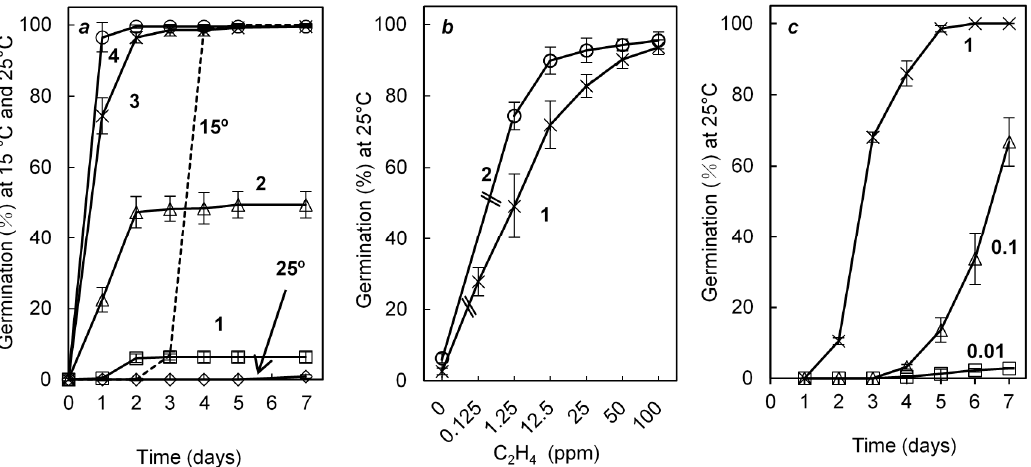
Figure 1. Effects of temperature ( a ), ethylene ( b ) and GA 3 ( c ) on the germination of dormant Col-0 seeds. ( a ) germination at 15 ◦ C (—) and 25 ◦ C (indicated by arrow, open diamonds), and at 25 ◦ C after one (1), two (2), three (3), and four (4) days of incubation at 4 ◦ C; ( b ) effects of ethylene concentration on the germination percentages obtained after seven days at 25 ◦ C with seeds placed directly at 25 ◦ C in the presence of C 2 H 4 (1) or after one day of incubation at 4 ◦ C (2); ( c ) effects of GA 3 concentration (mM) on the germination percentage obtained at 25 ◦ C. Seeds harvested in 2014. Means of 3 replicates ±